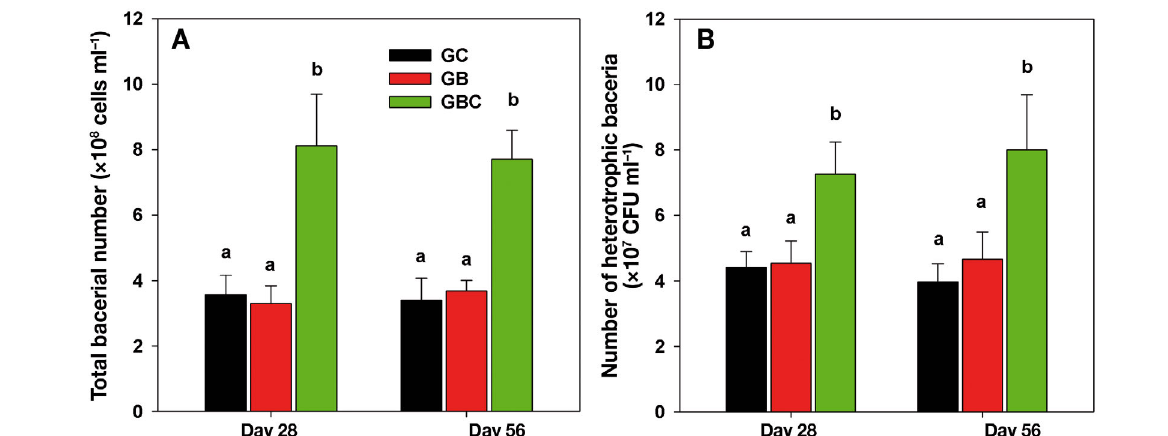
Fig. 3. Number (mean ± SD) of (A) total bacteria and (B) heterotrophic bacteria in different treatment groups (see Table 1) on Days 28 and 56. Different lowercase letters indicate significant differences among groups at the same sampling time (ANOVA, p <